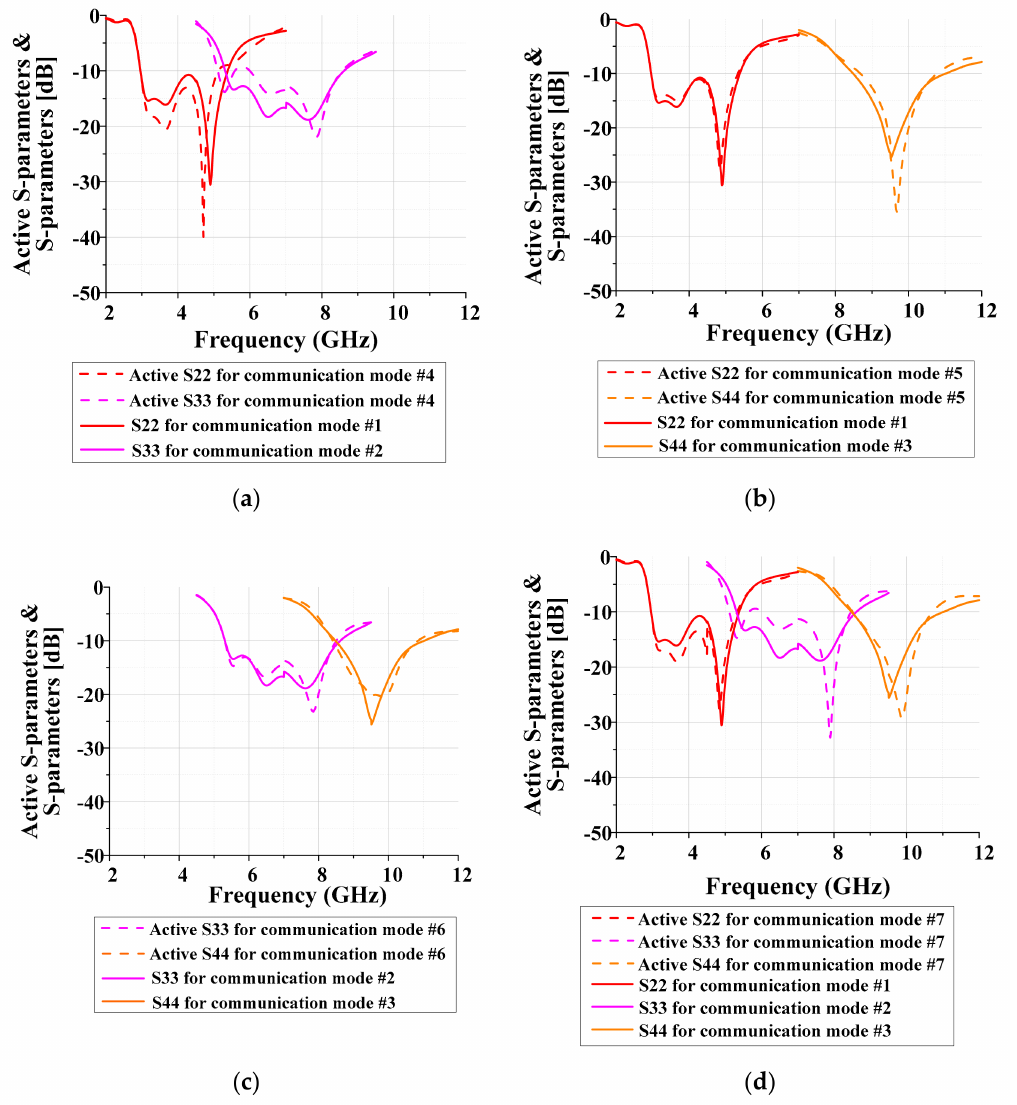
Figure 12. Comparisons of simulated active S-parameters for multi-communication and S-parameters for single communication: ( a ) communication mode #4 (P2 & P3 ON), ( b ) communication mode #5 (P2 & P4 ON), ( c ) communication mode #6 (P3 & P4 ON), and ( d ) communication mode #7 (P2 & P3 & P4 ON).